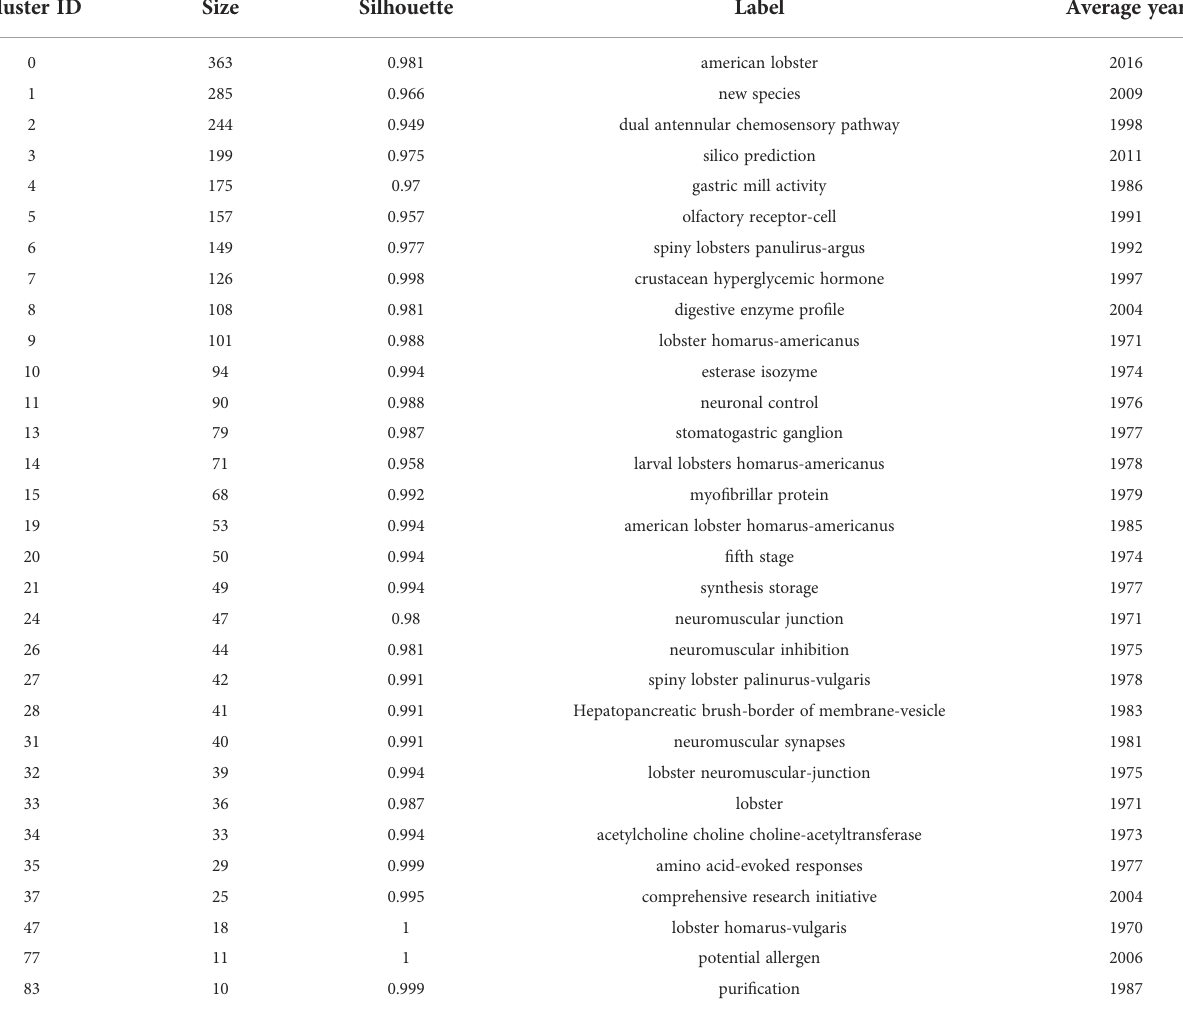
Size indicates the number of publications in the cluster.